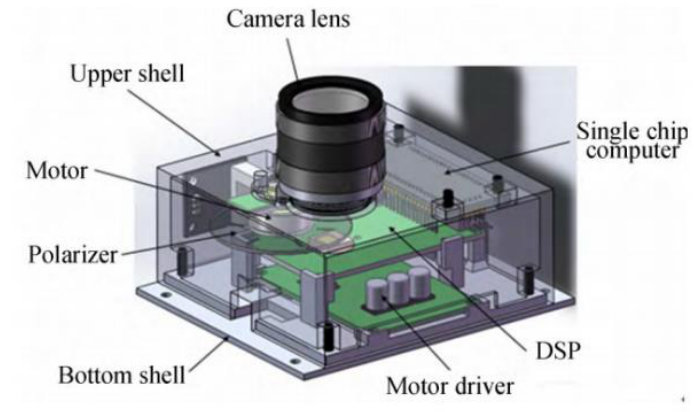
Figure 2. Structural design of rotary polarization imaging polarization camera [15].